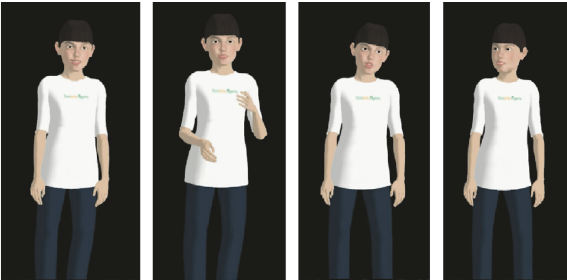
Figure 1: Examples of the presented nonverbal behavior smiling, expressive gesture, lateral head-tilt (cooperative nonverbal behav- ior), and avoiding gaze (noncooperative nonverbal